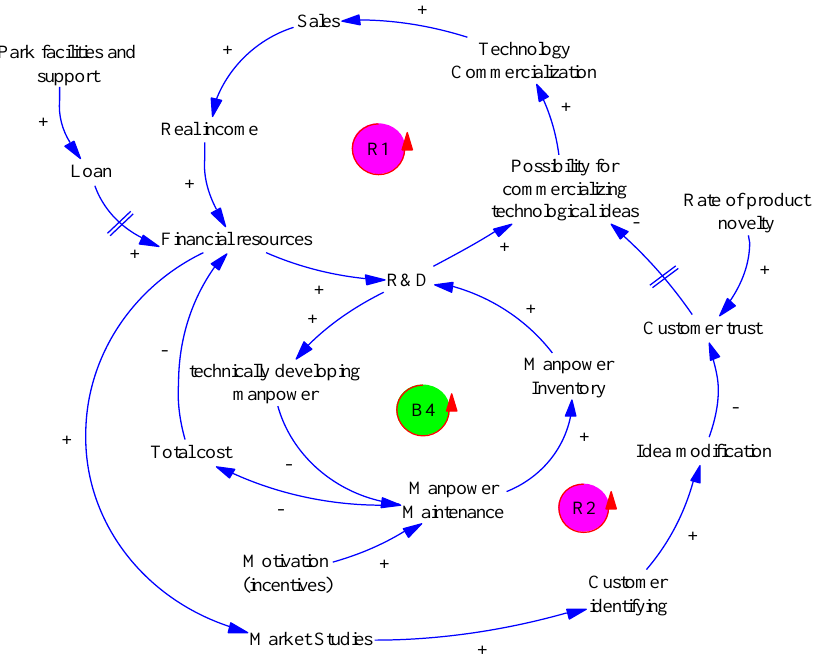
Figure 6. Allocation imbalance loop on technical development idea and management development